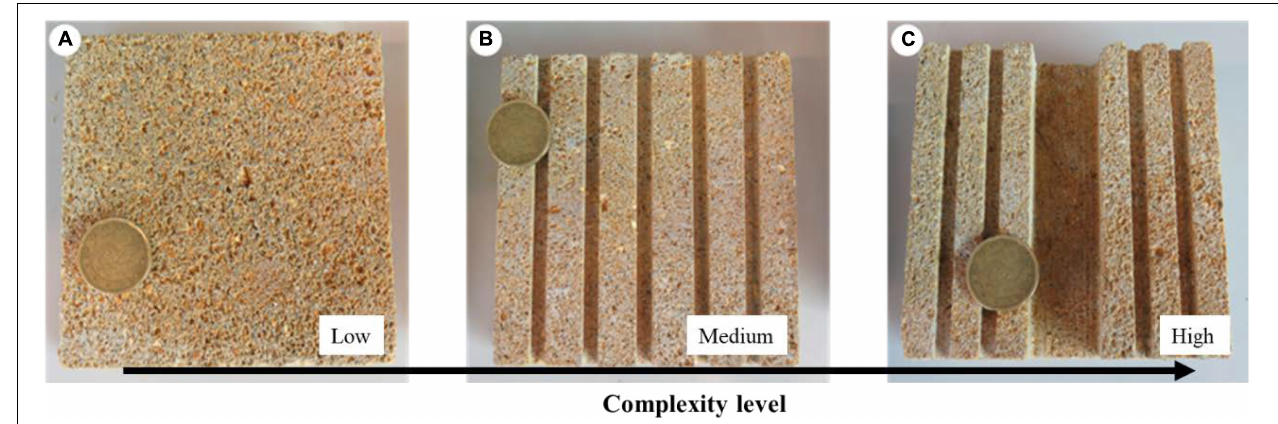
FIGURE 1 | Calcareous tiles characterized by three levels of complexity on which the seedlings were grown. (A) Low complexity, (B) medium complexity with five linear crevices 0.4 × 0.4 cm, and (C) high complexity with four linear crevices of 0.4 × 0.4 cm and a slot of 2 × 1 cm. The diameter of the coin is 22.25